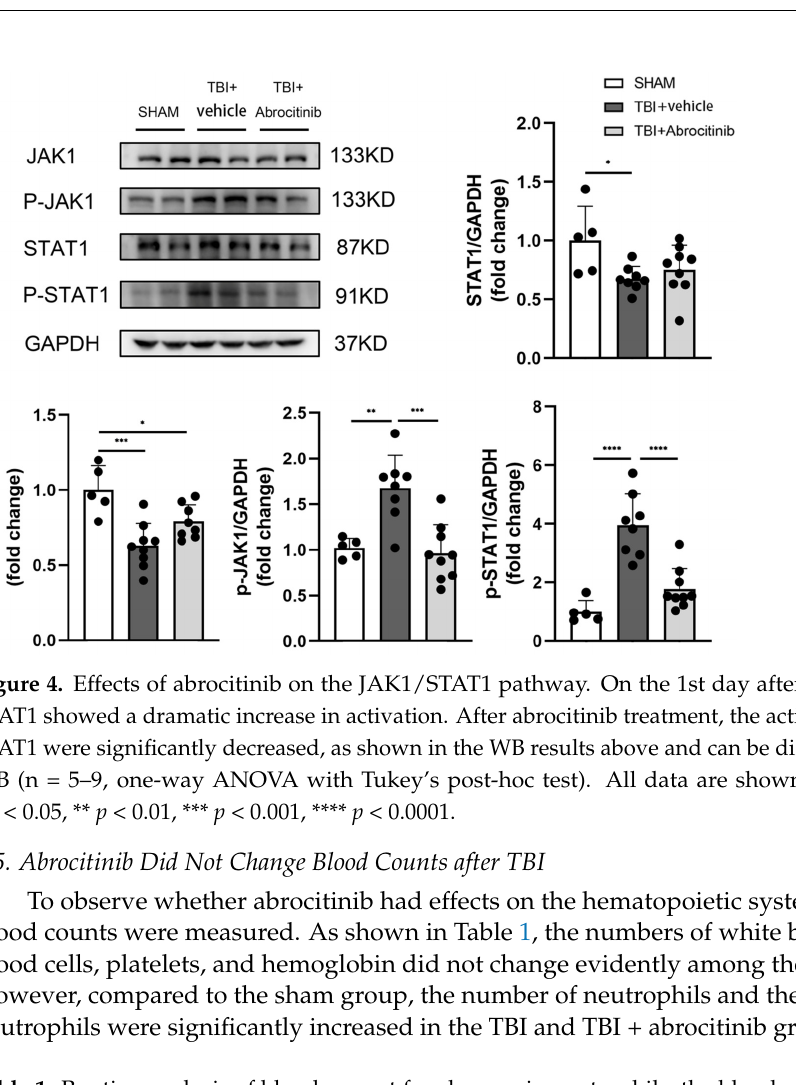
Table 1. Routine analysis of blood, except for changes in neutrophils, the blood counts of the TBI mice receiving abrocitinib or saline remained stable after treatment initiation ( p > 0.05). Eight samples were included in each group (Kruskal-Wallis test). * p < 0.05, ** p <